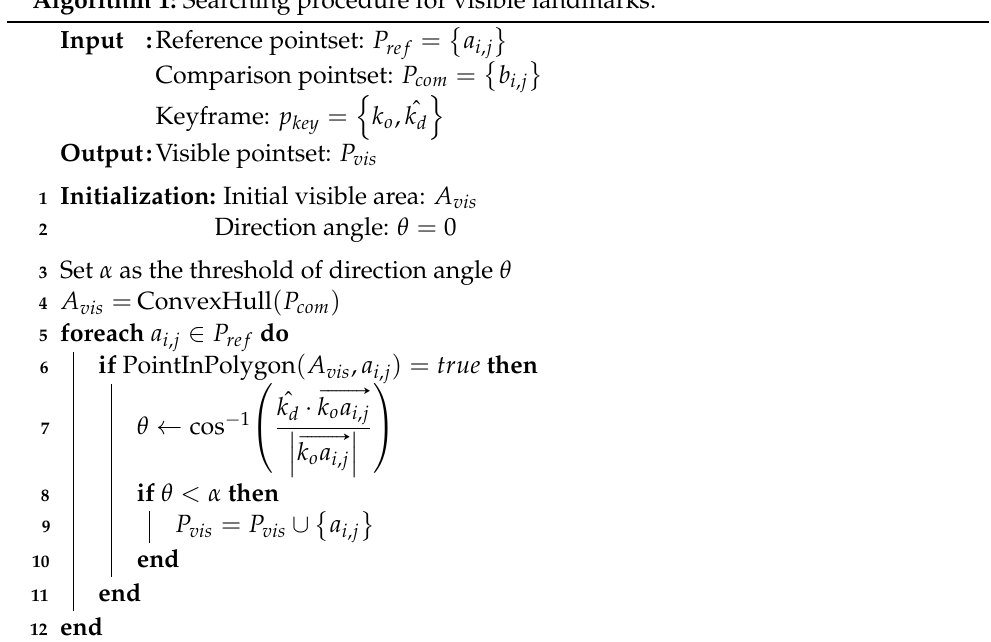
Algorithm 1: Searching procedure for visible